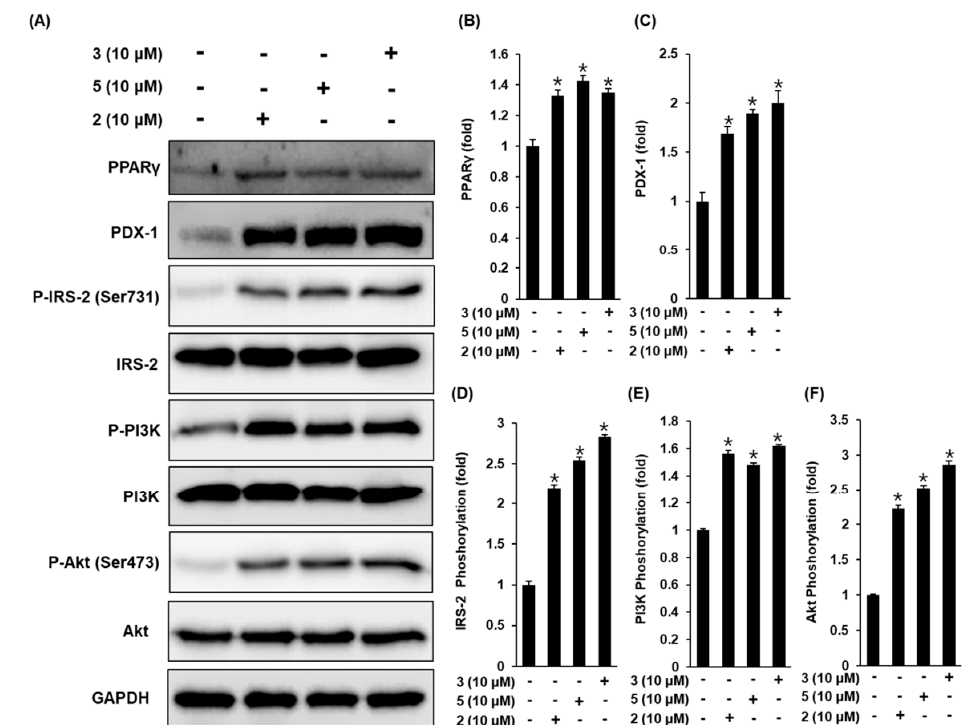
Figure 4. Effect of compounds 2 , 3 , and 5 isolated from A. membranaceus on the protein expression levels of peroxisome proliferator-activated receptor- γ (PPAR- γ ), pancreatic and duodenal homeobox-1 (PDX-1), P-insulin receptor substrate-2 (IRS-2) (Ser731), IRS-2, P-phosphatidylinositol 3-kinase (PI3K), PI3K, P-Akt (Ser473), and Akt in INS-1 cells. ( A ) Protein expression levels of PPAR- γ , PDX-1, P-IRS-2 (Ser731), IRS-2, P-PI3K, PI3K, P-Akt (Ser473), Akt, and glyceraldehyde 3-phosphate dehydrogenase (GAPDH) in INS-1 cells treated or untreated with 10 μ M compounds 2 , 3 , and 5 for 24 h. ( B – F ) Each bar graph presents the densitometric quantification of Western blot bands. * p < 0.05 compared to the control (0 μ M).